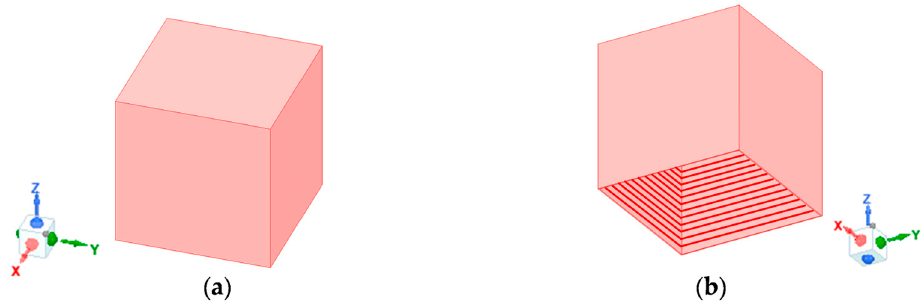
Figure 2. Open prism without a bottom face: ( a ) Trimetric view from above; ( b ) Trimetric view from below (inside of the open prism is shaded with red lines).